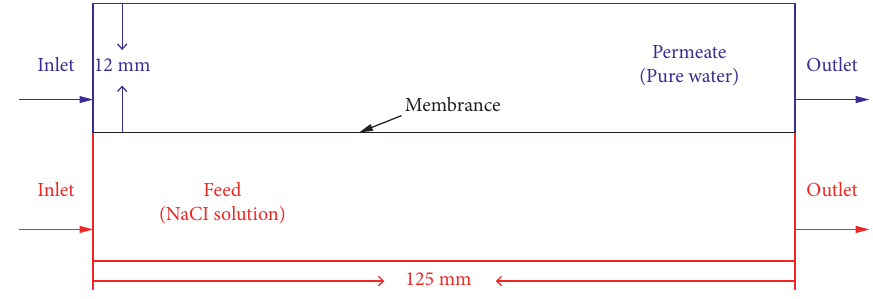
Figure 2: 2D geometric model of the experimental MD module. Table 1: Properties of the PVDF membrane.